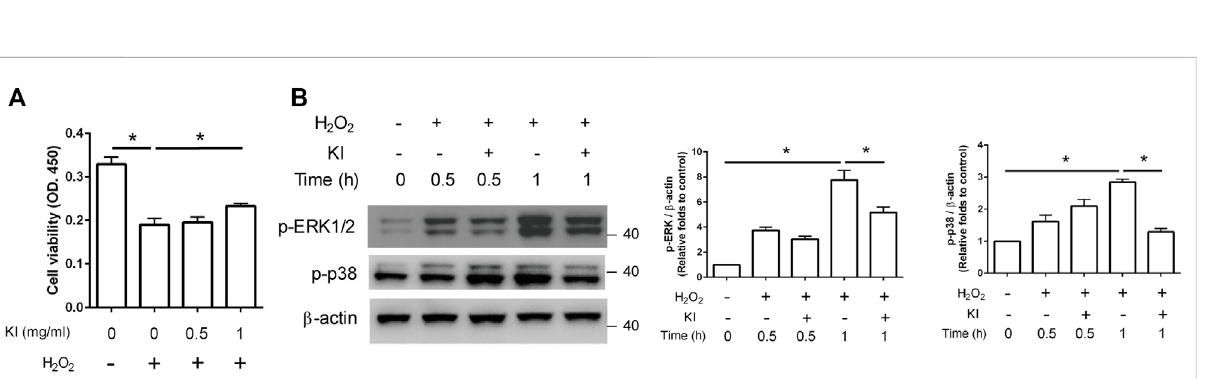
FIGURE 3 Protective effect of KI Essence extract treatment on PC12 cells against H 2 O 2 -induced cell death through inhibition of ERK phosphorylation. (A) PC12 cells weretreated with 200 µM H 2 O 2 and variousconcentrations of the KI Essence extract for 1 day. Viability of PC12 cells was measured using CCK-8 assay. The results are presented as means ± standard errors of means (SEMs; n = 3; p p < 0.05). (B) PC12 cells treated with 1 mg/ml KI Essence extract for various durations (0, 0.5, and 1 h) in the presence of 200 µM H 2 O 2 . Levels of p-ERK1/2, p-p38, and β -Actin were analyzed through Western blotting. Quantitation of p-ERK1/2 and p-p38 to β -Actin is presented in the bar graph. The results are presented as means ± SEMs ( n = 3; p p <